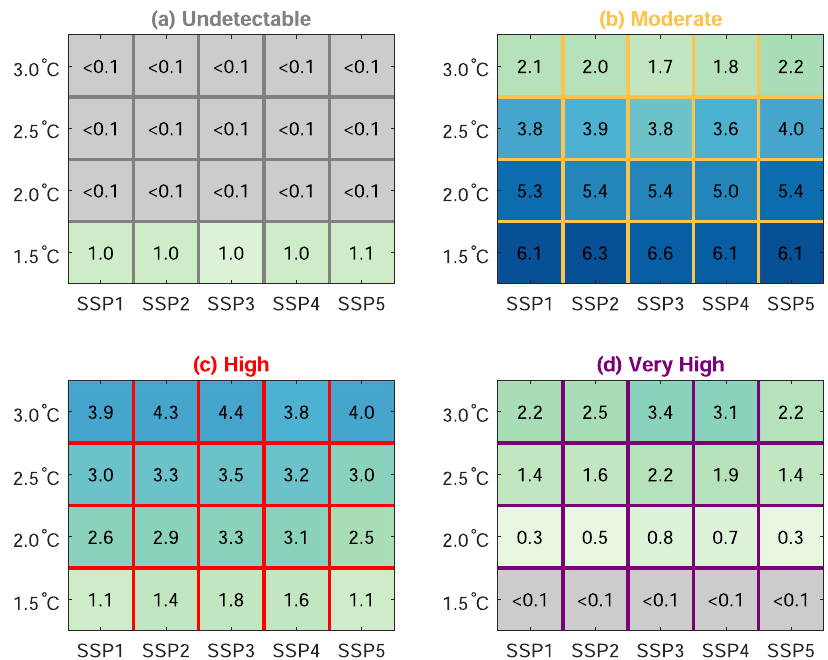
Fig. 3 Socioeconomic and emissions scenario uncertainty in local heat risks. Each panel shows the number of people locally exposed to each of the four risk categories designated in Fig. 2, using population data from fi ve socioeconomic scenarios (SSPs) in the year 2050, and calculating exposure levels for a range of speci fi ed global warming thresholds. The numbers in the boxes denote billions of people associated with that risk category; the corresponding shading denotes the fraction of the global population associated with that risk category for that particular SSP